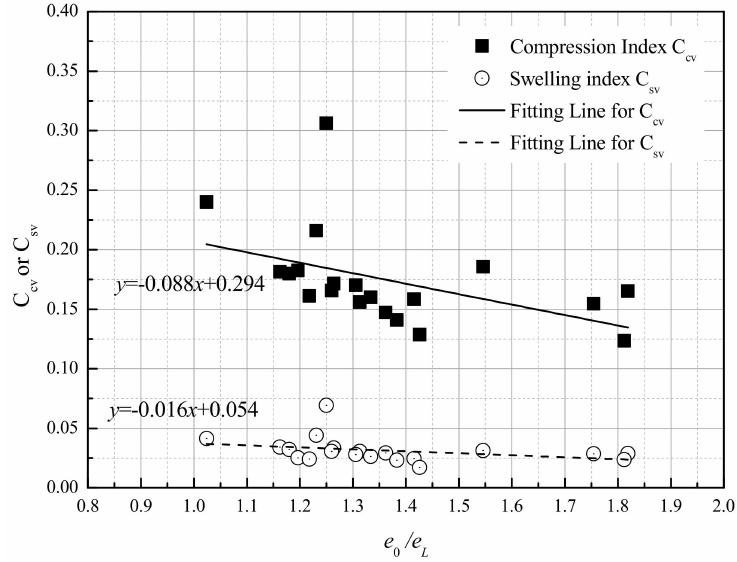
Figure 5. The relationship between liquid limits e 0 / e L and C cv or C sv